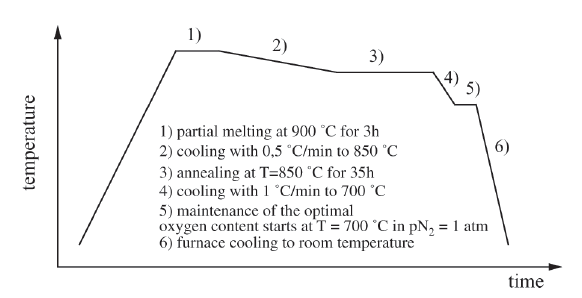
Figure 1. Applied PMR Thermal Cycle for production of bulk Bi Sr Ca Cu O . 2+x 3-y y 2 8+ ∆